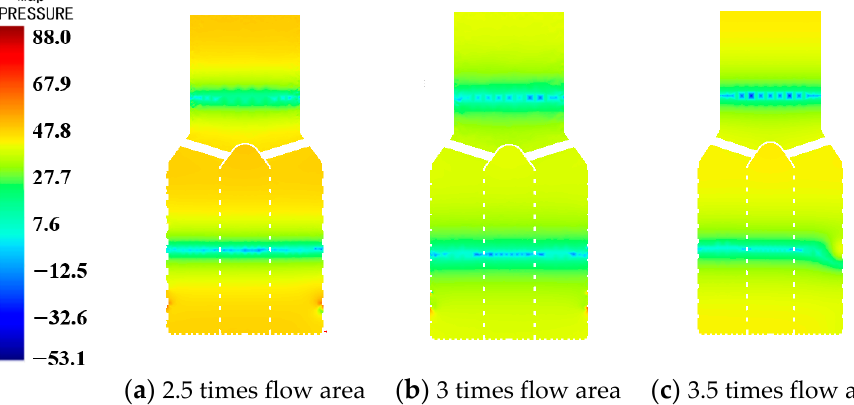
Figure 30. Sound pressure level distribution of different schemes at the second peak.